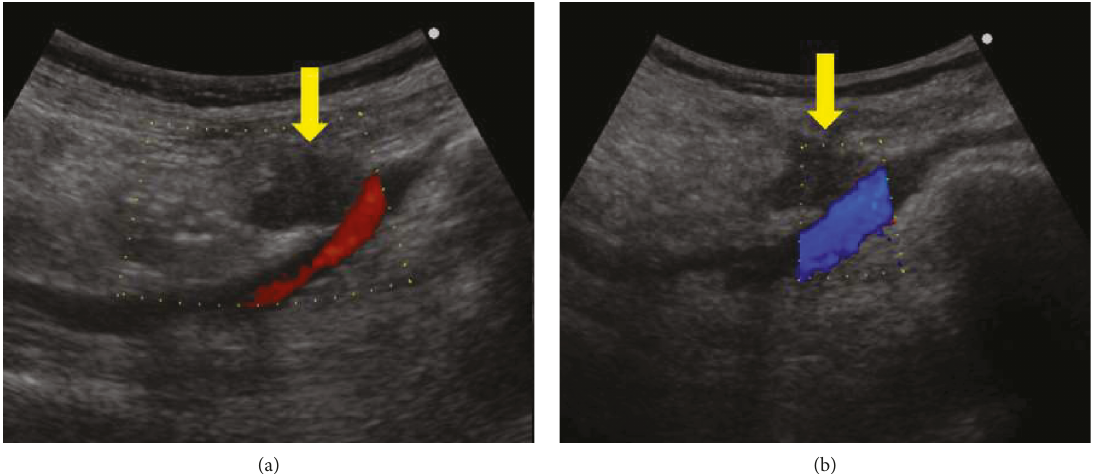
Figure 1: Ultrasonography showing a 27 × 16mm, irregular, low-echoic tumor (arrow). The tumor is located around the external iliac artery (a) and the external iliac vein (b).